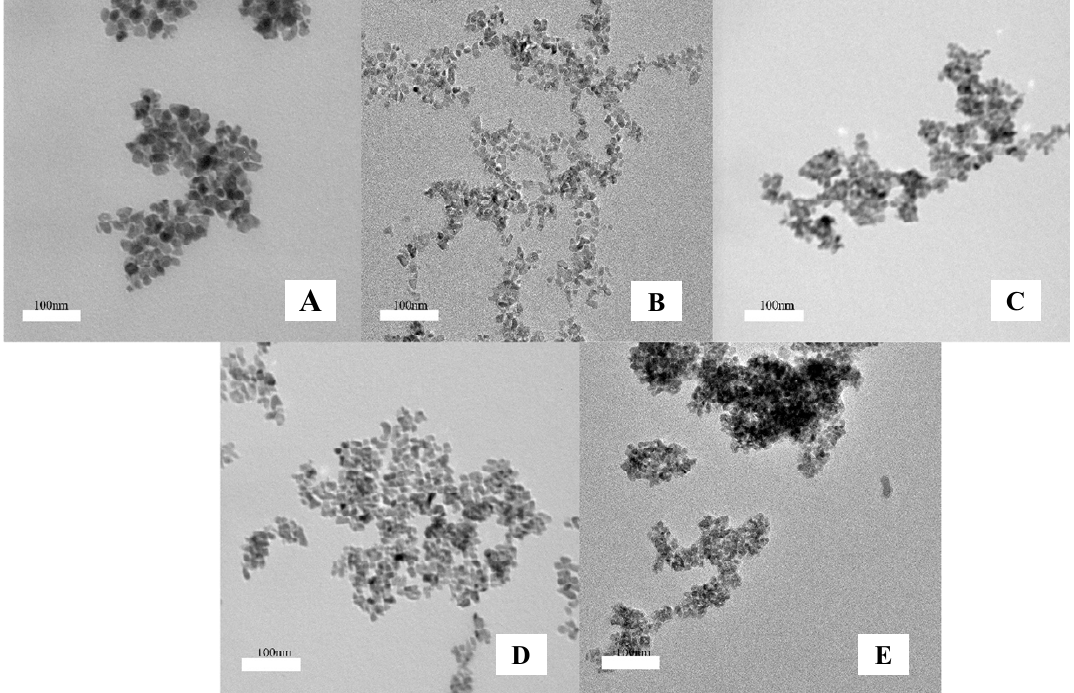
Figure 3. TEM images of the ( A ) ZrO 2 and ( B , C , D , and E : 0.5, 1, 3, and 5%) Zn–ZrO 2 NPs. The scale bar represents 100 nm.